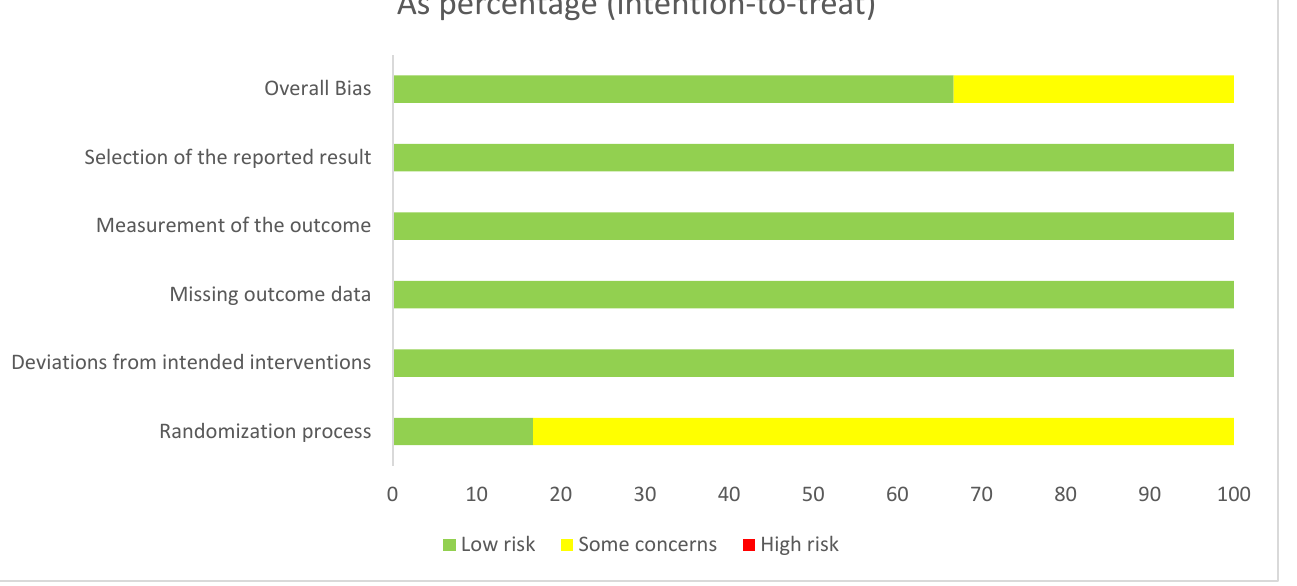
Figure 1. Risk of bias assessment tool. Across trials (n = 6). Information is either from trials at low risk of bias (green), or from trials with some concerns of bias (yellow), or from trials at high risk of bias (red).